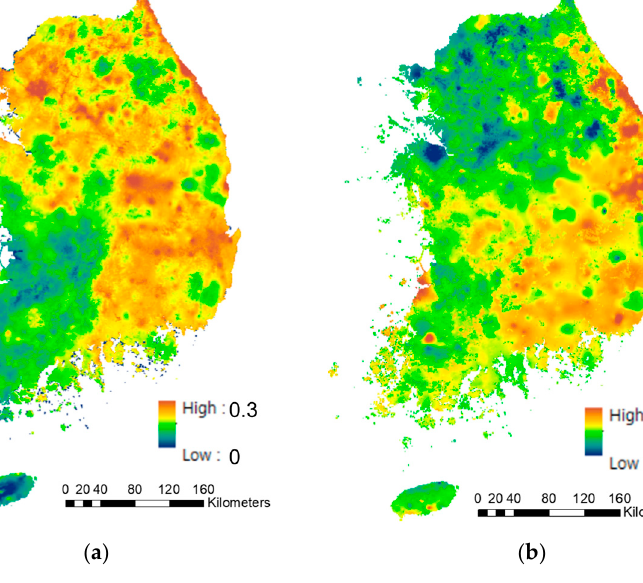
Figure 15. Trends of the ignition probability conditional on fuel moisture ( P m ) in spring season: ( a ) average P m , ( b ) slope of the time-series P m , ( c ) Pearson’s correlation coefficient of the time series P m .